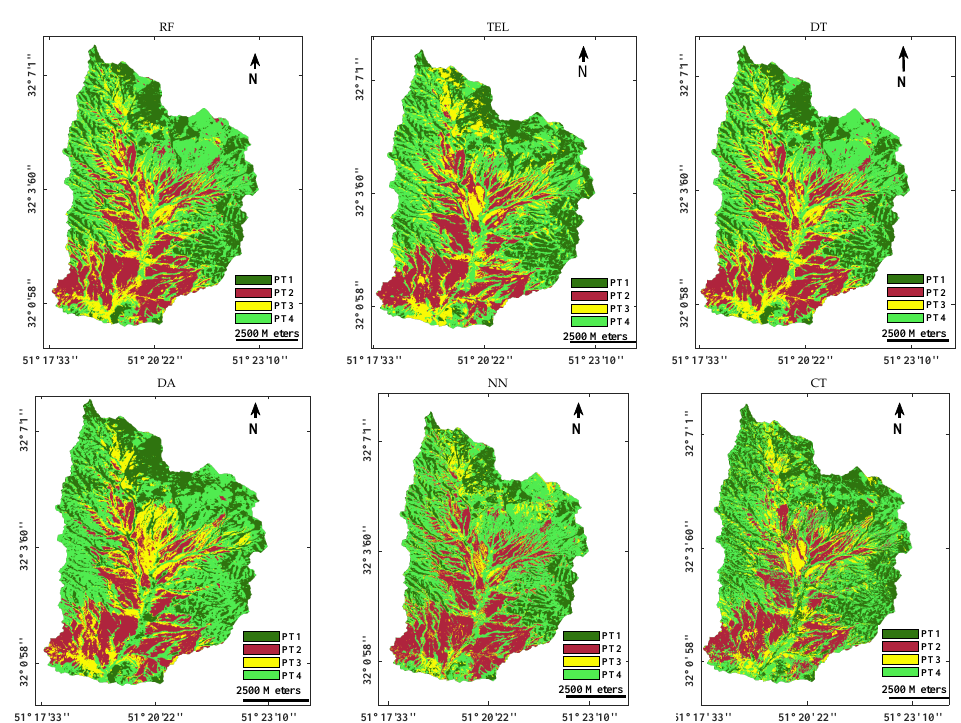
Figure 7. Thematic maps of PTs as obtained from the second- to seventh-best validated classifiers (see Table 3). RF: random forests, TEL: tree-ensemble learning (bag), DT: decision tree (ECOC), DA: discriminant analysis (ECOC), NN: neural network (Adam), CT: classification